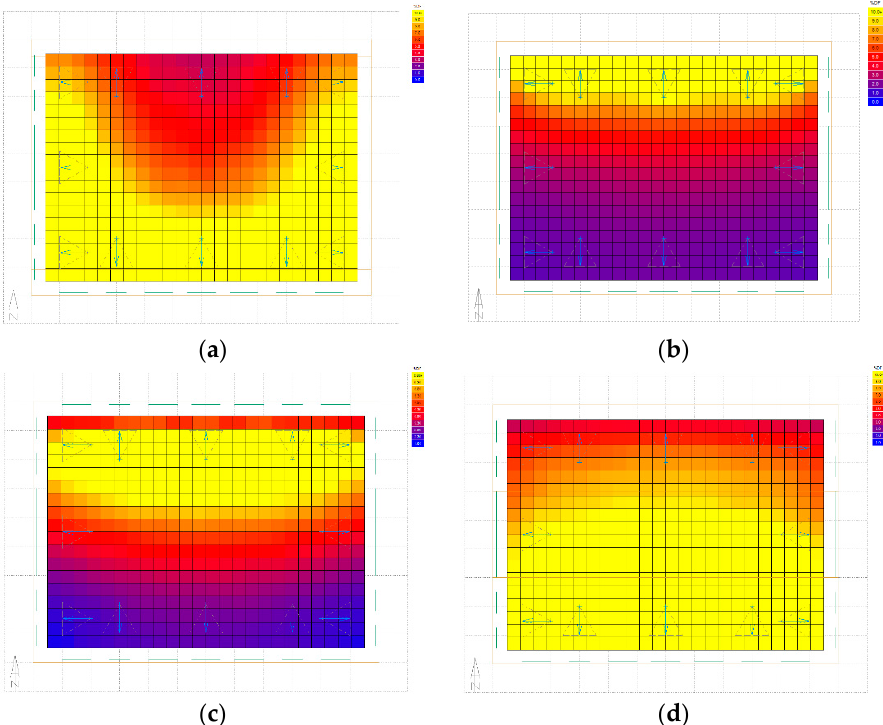
Figure 10. Planar distribution of DF s of different types of window: ( a ) flat skylight; ( b ) low side window; ( c ) high side window; ( d ) sawtooth skylight.